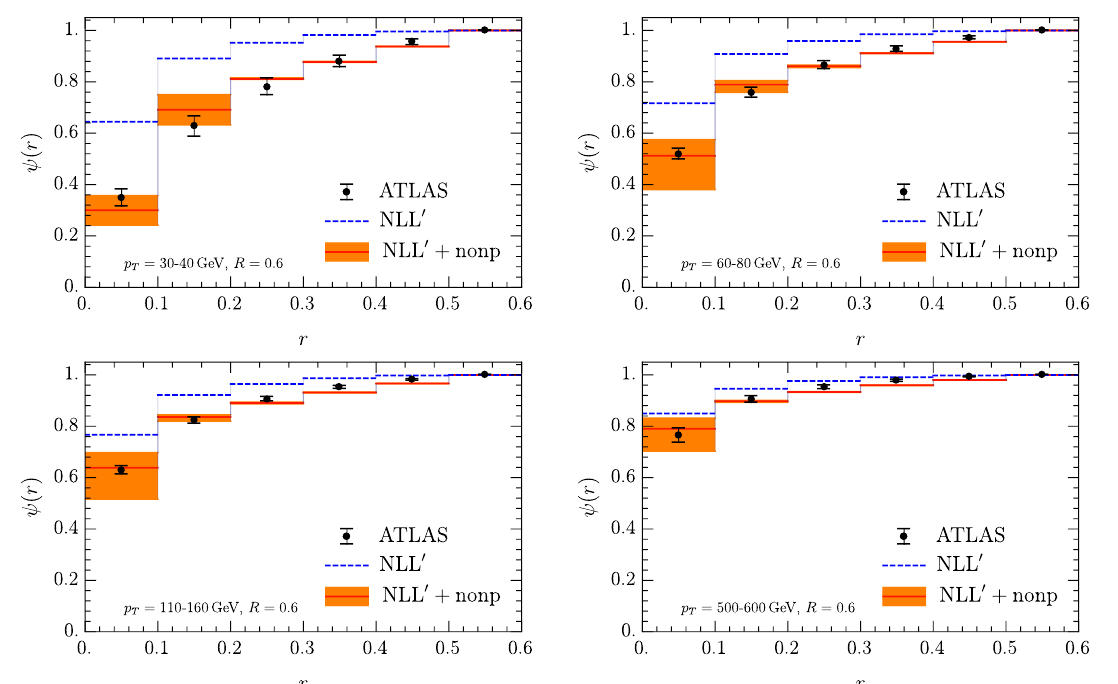
Figure 11 . Comparison of our theoretical calculation at NLL 0 accuracy for the inclusive jet shape ( r ) to the data from ATLAS [19]. The inclusive anti-k T jet sample is reconstructed for a jet radius of R = 0 : 6 and (cid:17) < 2 : 8 measured at E cm = 7 TeV. Four representative jet p T intervals in j j the range 30{600 GeV are shown, as indicated in the panels. Our purely perturbative calculation is shown (dashed blue), along with the results that include the nonperturbative e(cid:11)ects through a model (orange) and perturbative uncertainty